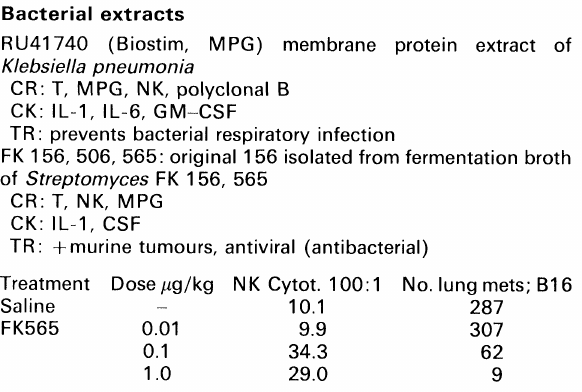
Table 8. Biological response modifiers of bacterial origin